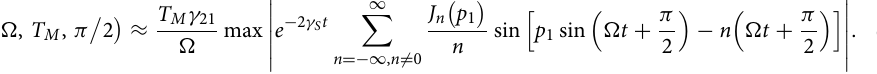
γ 21 is plotted in 2 for SMS with γ S 3 γ 21 and for RMS with γ S = =